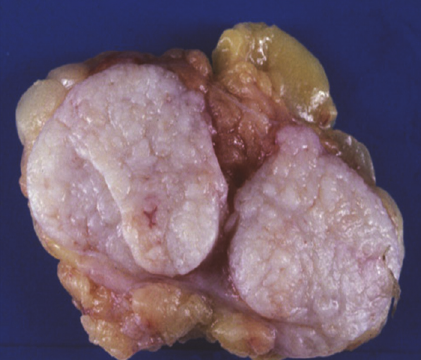
Figure 4: A 1.8 × 1.2 cm round multinodular soft mass, with well-circumscribed lobulated contours, focal with irregular borders.